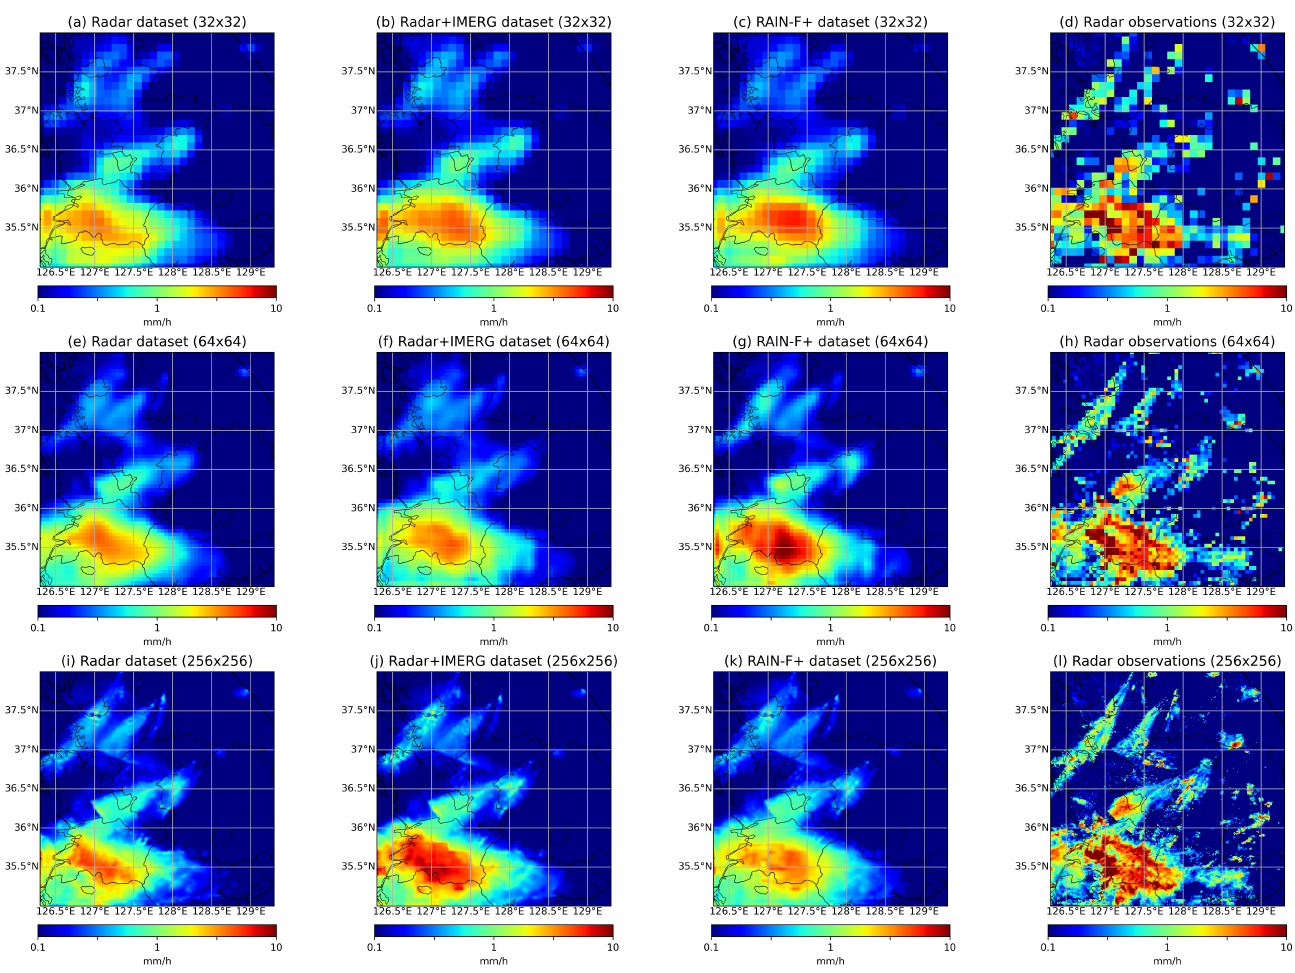
Figure 8. The examples on 01 UTC 27 July 2019 of prediction results with RAIN-F+ dataset, radar and IMERG fusion dataset, radar only dataset, and reference radar observations depending on the resolution of 32 × 32 ( upper row ), 64 × 64 ( middle row ), and 256 × 256 ( bottom row ).